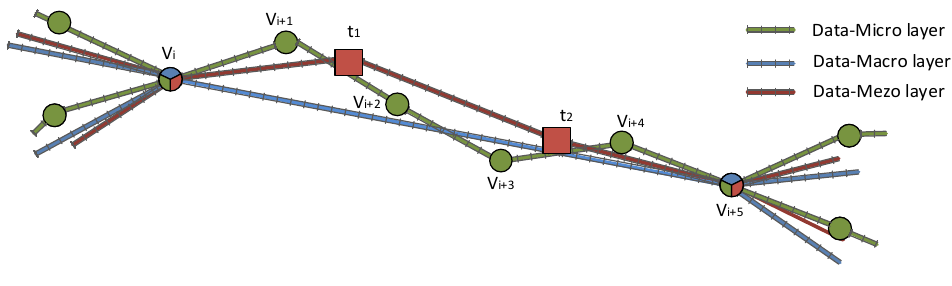
Figure 3. Concept of a three-layer rail line model.